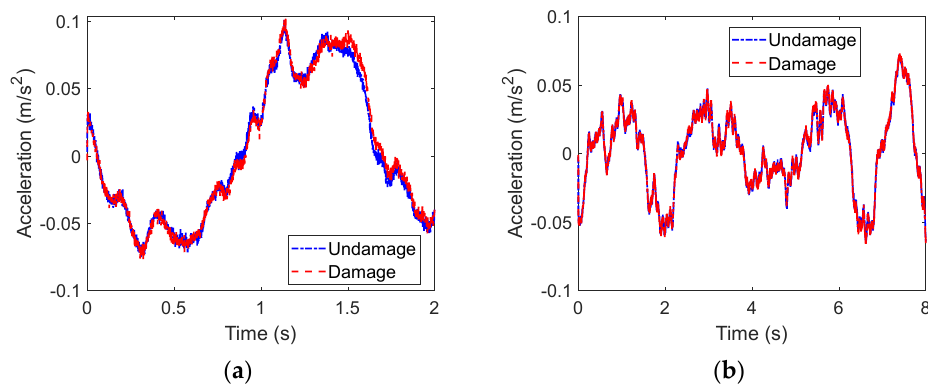
Figure 16. Vehicle acceleration with noise. ( a ) 𝑣 = 10 m/s; ( b ) 𝑣 = 2.5 m/s.